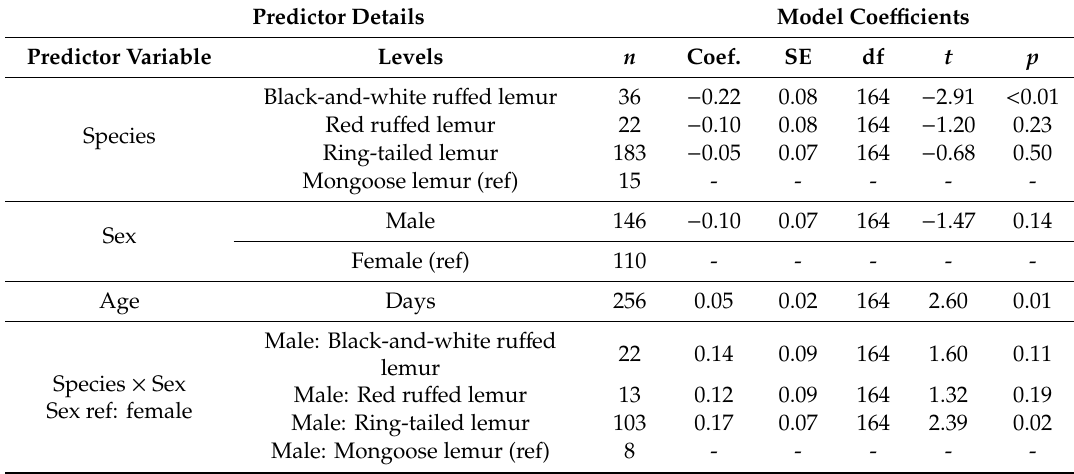
Table A6. Details of baseline model featuring three predictors, and one interaction, all previously identified as having a univariable relationship with relative body mass (Table A5). The species × sex interaction was found to be a better fit to the data than a simpler model without it (AIC = − 211.93 v − 216.09). Random e ff ects were ‘enclosure’ nested in ‘zoo’. For each predictor varying intercepts but common slopes were found to be the best fit to the data. n = number of animals. Coef. = coe ffi cient. SE = standard error. df = degrees of